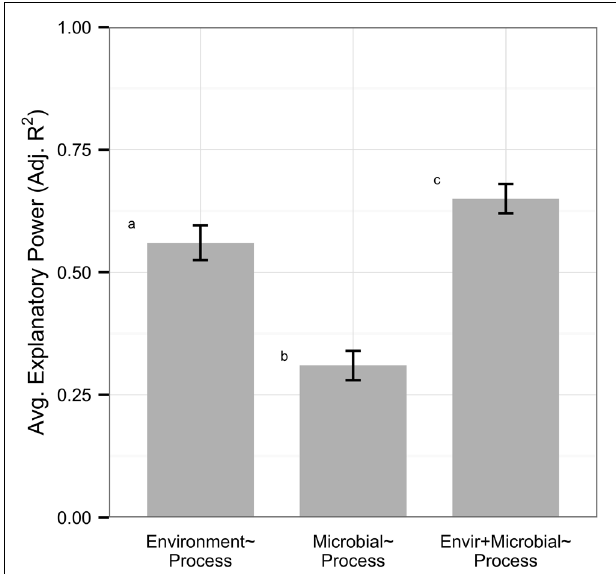
FIGURE 1 | Within the full dataset ( n = 82), environmental variables explained more variation in ecosystem process rates than microbial community structure. Microbial predictors alone had low explanatory power on processes but improved model explanatory power on average. Error bars denote standard errors, and letters represent significantly different groups (Mann–Whitney U , p <